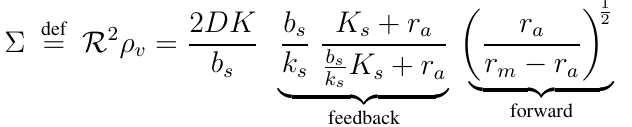
Figure 2. Log-log plot of signal molecule production, κ = [R S ] . The feedback loop ignites when the signal molecule production concentration, r a 2 2 starts rising from the background